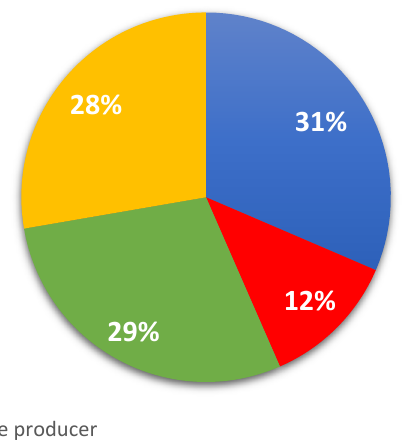
Figure 8. Responsible for preventing DoS attacks. Source: Author’s processing.